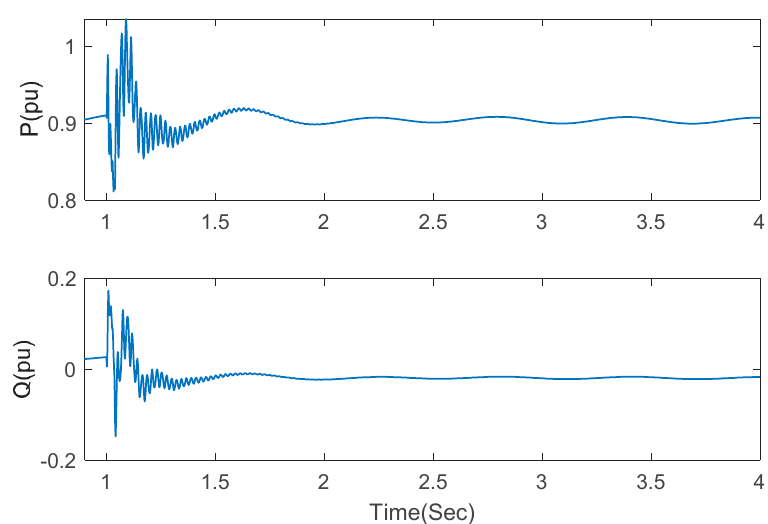
Figure 13. Responses of active power and reactive power under asymmetric fault in series ‐ compensated wind farm.